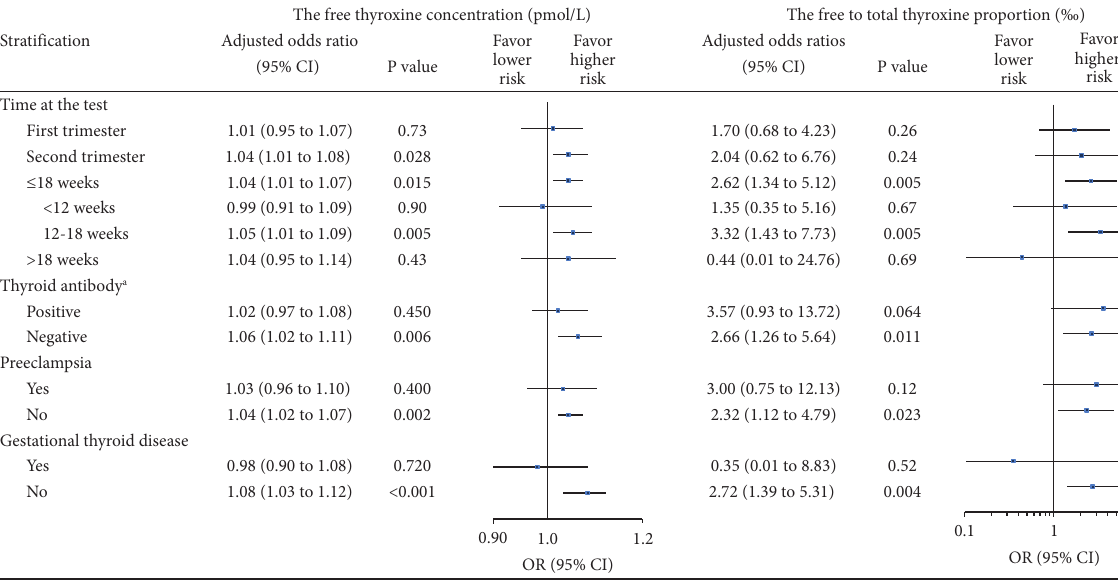
Figure 3: Association of the FT4 and FTT4P with the risk of congenital heart defects in stratification analyses. Abbreviations: FT4, free thyroxine; TT4, total thyroxine; FTT4, free-to-total thyroxine; and 95% CI, 95% confidence interval. a Thyroid antibody positive was defined as any one positive of the three markers, including thyroperoxidase antibody ( > 34 IU/ml), thyroglobulin antibody ( > 115 IU/ml), or thyroid- stimulating hormone receptor antibody ( > 1.75